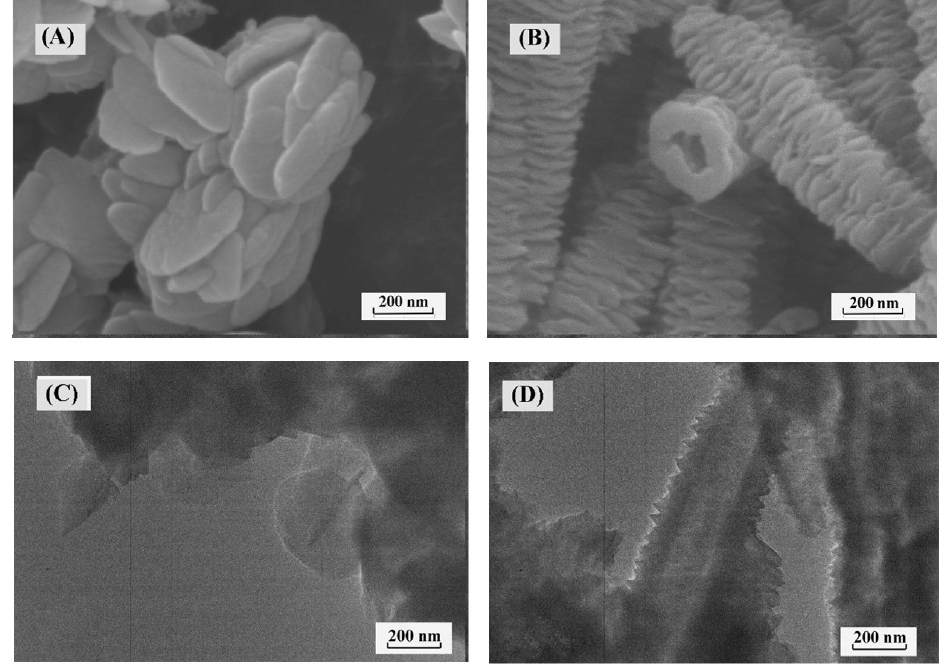
Figure 3. SEM of PyT-1 ( A ) and PyT-2 ( B ); TEM of PyT-1 ( C ) and PyT-2 ( D ). To characterize the porosity of the COFs, an experiment was performed using nitrogen adsorption isotherms. The two COFs exhibited the typical II adsorption isotherms. How- ever, a convex curve appeared in PyT-1 at a relatively lower pressure of 0.01 < P/P 0 <